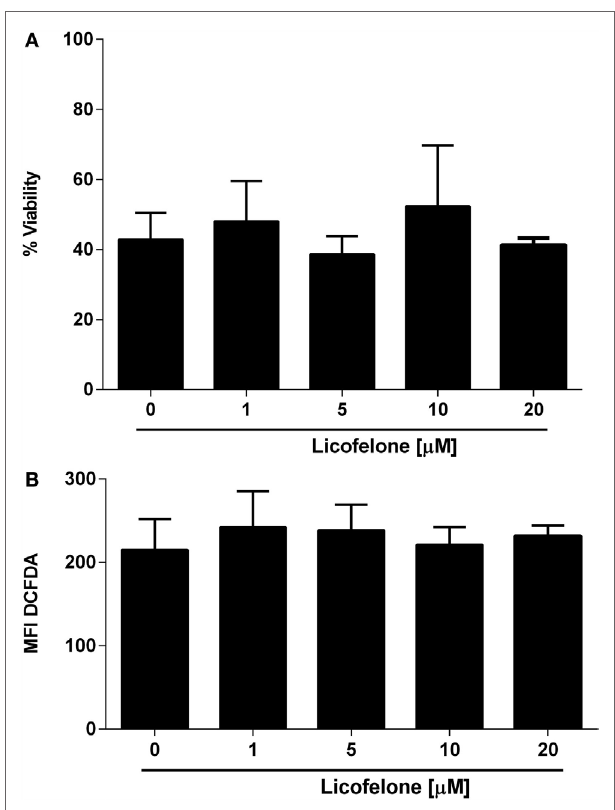
FigUre 3 | Viability (a) and rOs production (b) of melanoma cells derived ex vivo are not changed by licofelone treatment . B16F10luc2 melanoma cells were treated with licofelone at 1, 5, 10, or 20 μ M for 48 h. Data shown are the mean + SD from three individual